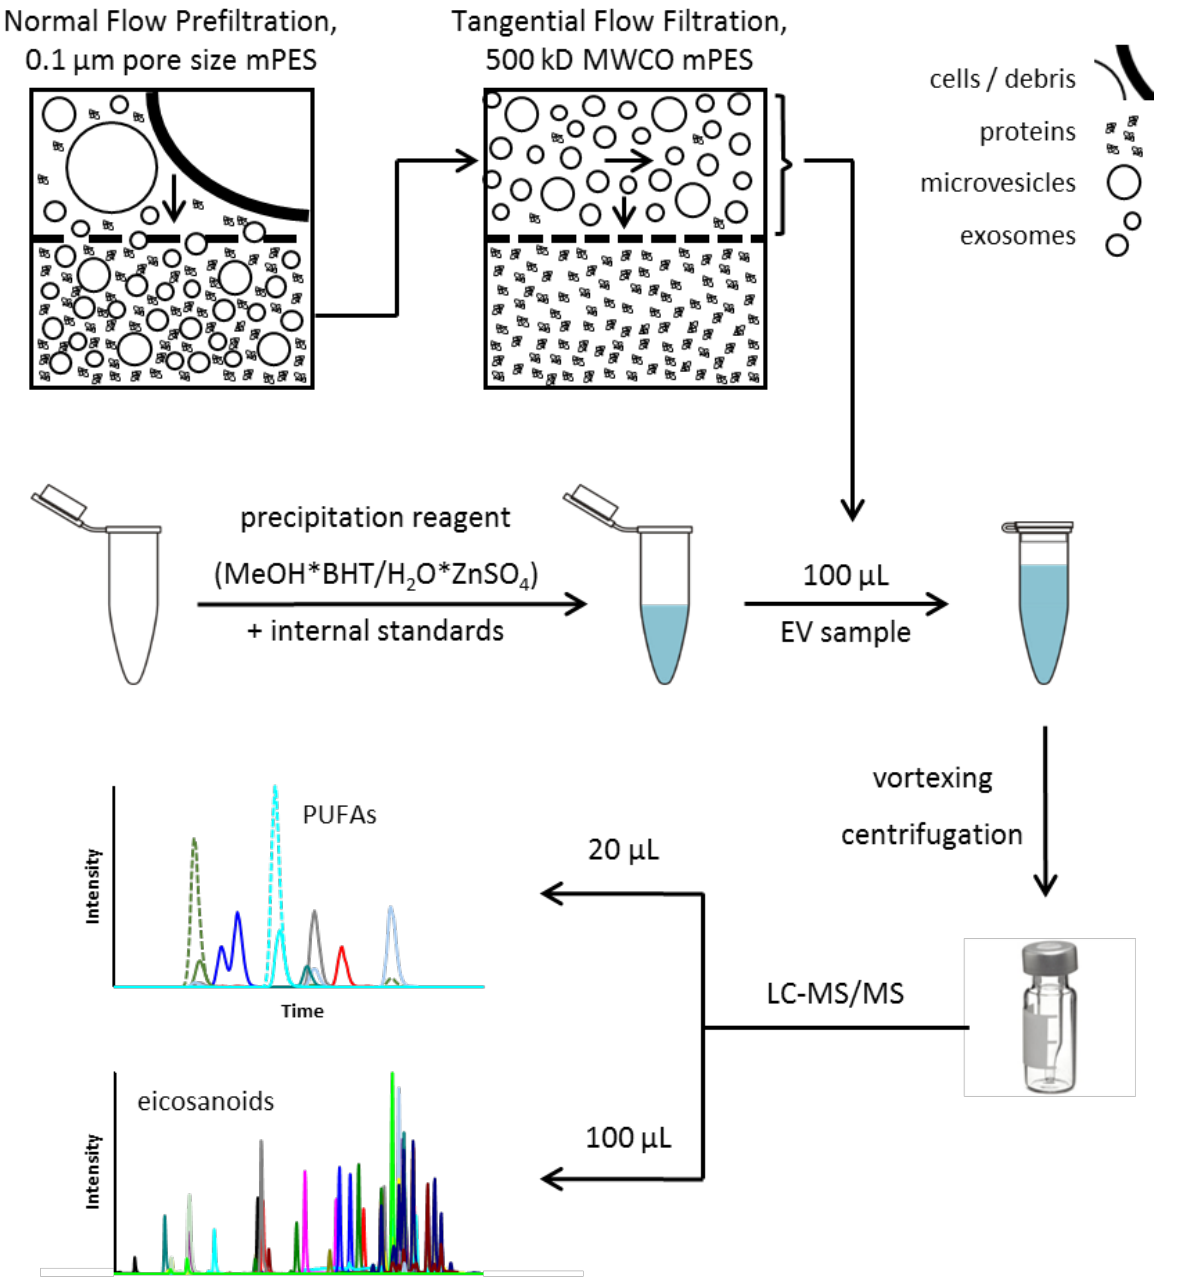
Figure 5. Final protocol for EV isolation and sample preparation for LC-MS/MS analysis of PUFAs and eicosanoids (adapted after [34]). BHT—butylated hydroxytoluene; EV—extracellular vesicles; LC-